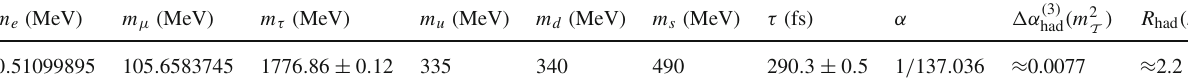
Fig. 2 Leading-order energy levels and lifetimes of the three lowest ( n = 1 , 2 , 3) para- ( n 1 S 0 ) and ortho- ( n 3 S 1 ) ditauonium states decaying into a pair of photons and of lighter charged fermions ( f f = e + e − , μ + μ − , qq ),